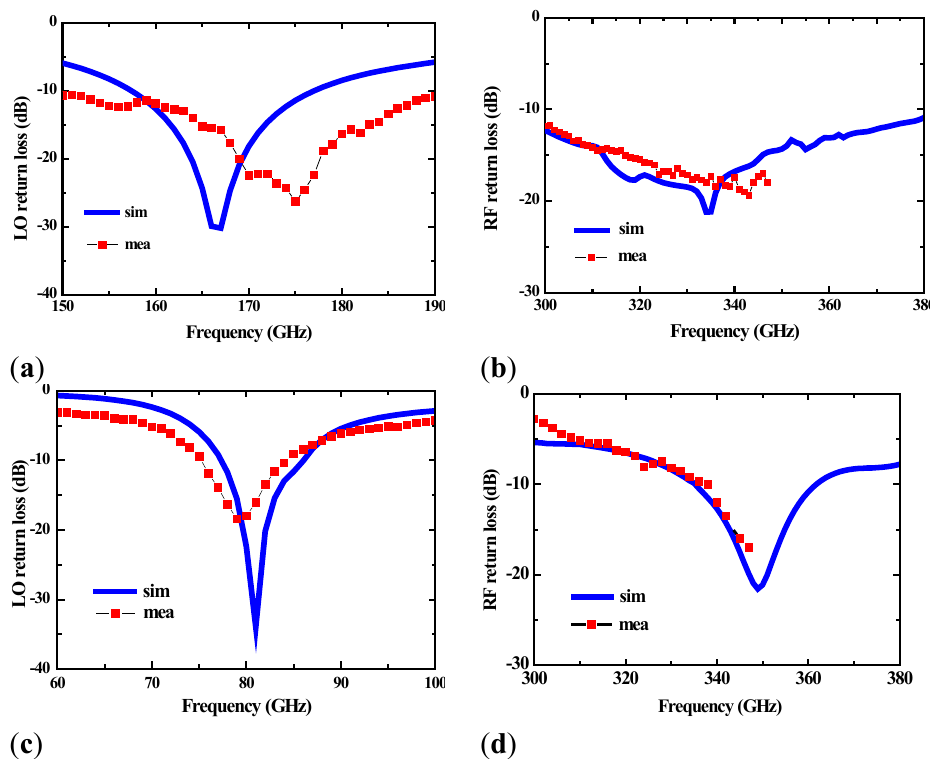
Figure 5. Measured and simulated S parameters of the 2× and 4× SHMs: ( a ) Return losses at LO port of the 2× SHM; ( b ) return losses at RF port of the 2× SHM; ( c ) return losses at